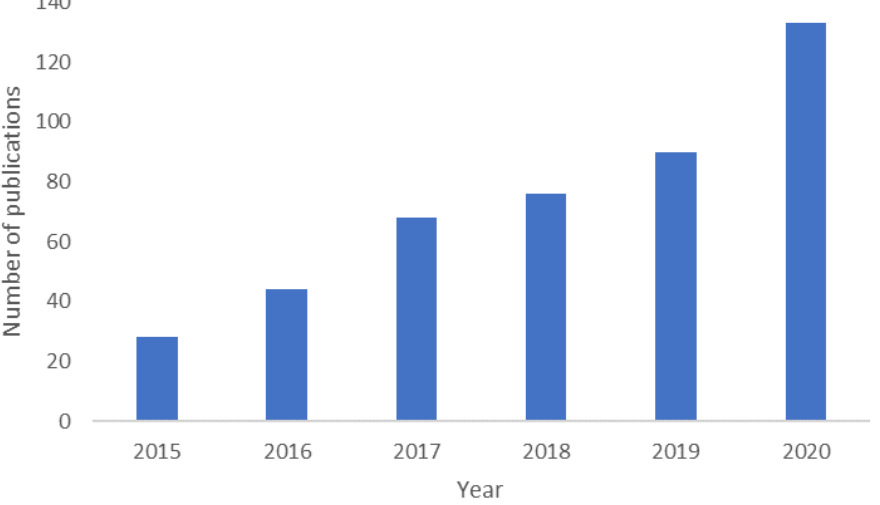
Figure 2. Number of publications in the field of 3D in vitro cancer models in the past five years. The graph is based on the search results using the keywords “3D models” and “cancer” from 2015 to 2020 for documents in English in Scopus. The findings are further narrowed down to those publications which either use 3D in vitro models to study aspects of cancer or describe the development of a new platform.